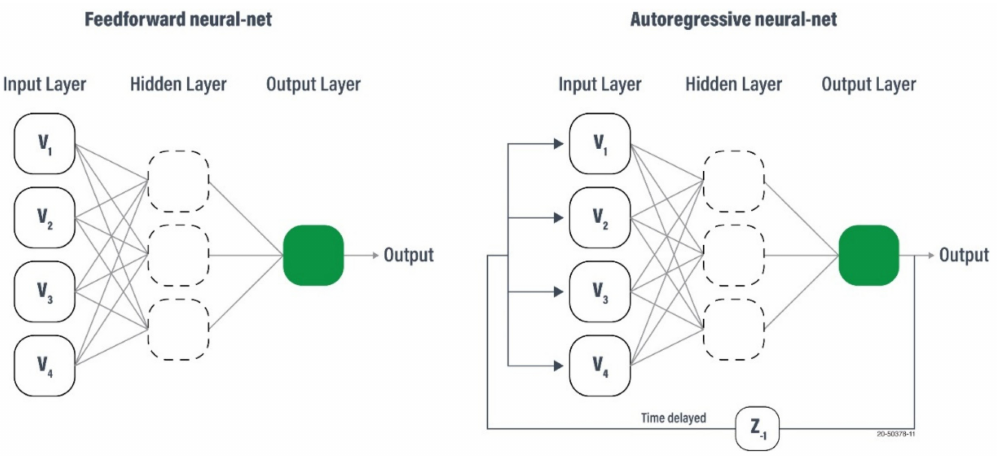
Figure 5. Simple schematic of feedforward and autoregressive neural